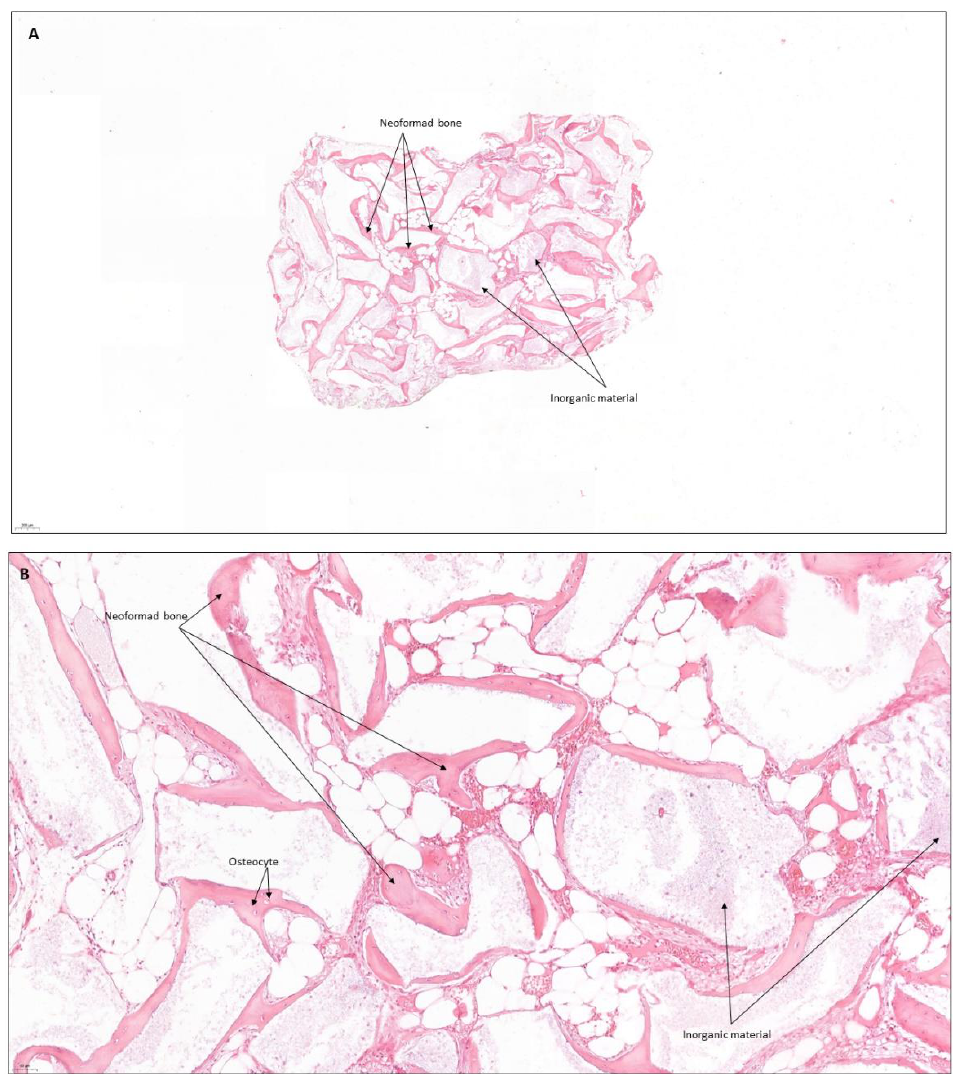
( D ) Postoperative occlusal view; ( E ) One-week follow-up.